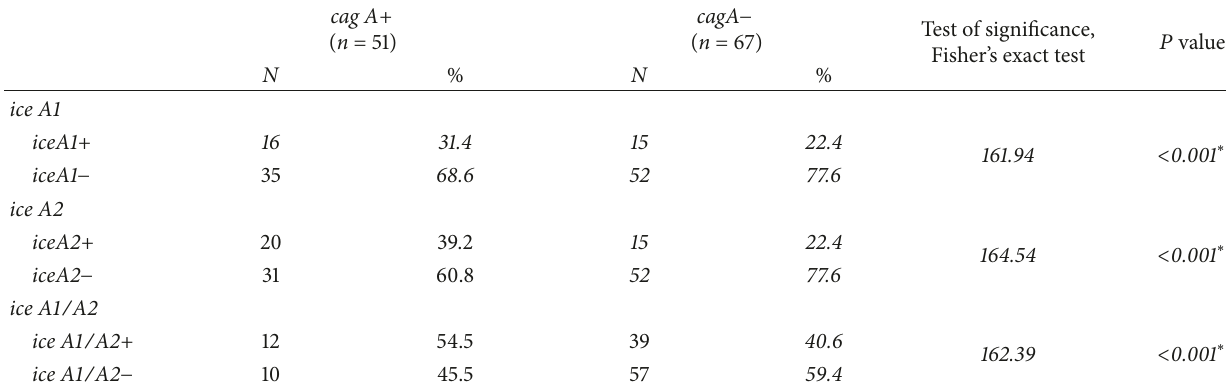
Table 3: Association between cagA and IceA